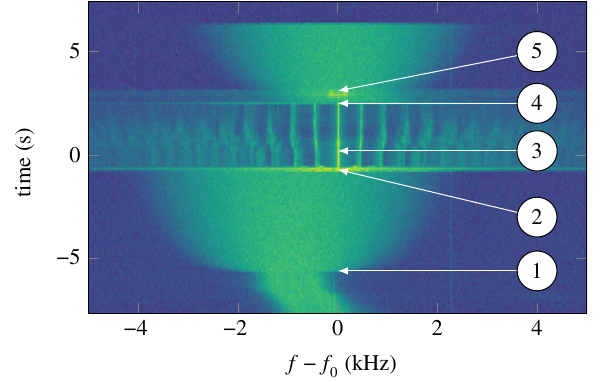
FIG. 6. Example of a spectrogram of the 17th revolution harmonic and its synchrotron sidebands measured by the ¼ 1 kV, electron Schottky pickup at f 0 ¼ 3 . 256 MHz. V rf ; set bunch length 500 ns. The color corresponds to a logarithmic scale of spectral power density. t ¼ 0 denotes the beginning of BPM data acquisition. (1) dc cooler is switched off. (2) Beam starts being bunched. (3) Start of pulsed cooling. (4) rf is switched off. (5) End of pulsed